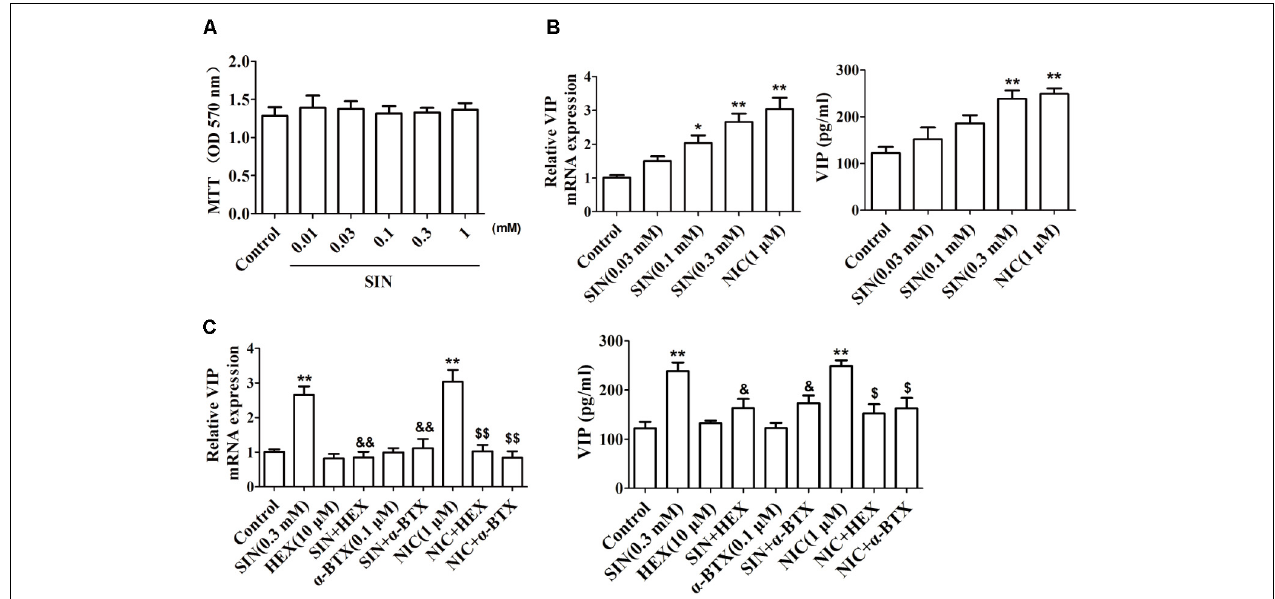
FIGURE 5 | Effect of sinomenine (SIN) on the expression of VIP in PC-12 cells. (A) Effect of SIN on the cell viability of PC-12 cells was measured by MTT assay. (B) Effect of SIN and nicotine (NIC) on the mRNA expression and protein level of VIP in PC-12 cells were measured by quantitative PCR assay and ELISA respectively. (C) Effects of hexamethonium (HEX) and α -bungarotoxin ( α -BTX) on the up-regulated VIP level by SIN and NIC in PC-12 cells were measured by quantitative PCR assay and ELISA respectively. Data were expressed as means ± SEM of three independent experiments. ∗ P < 0.05 and ∗∗ P < 0.01 versus Control; $ P < 0.05 and $$ P < 0.01 versus NIC; & P < 0.05 and && P < 0.01 versus